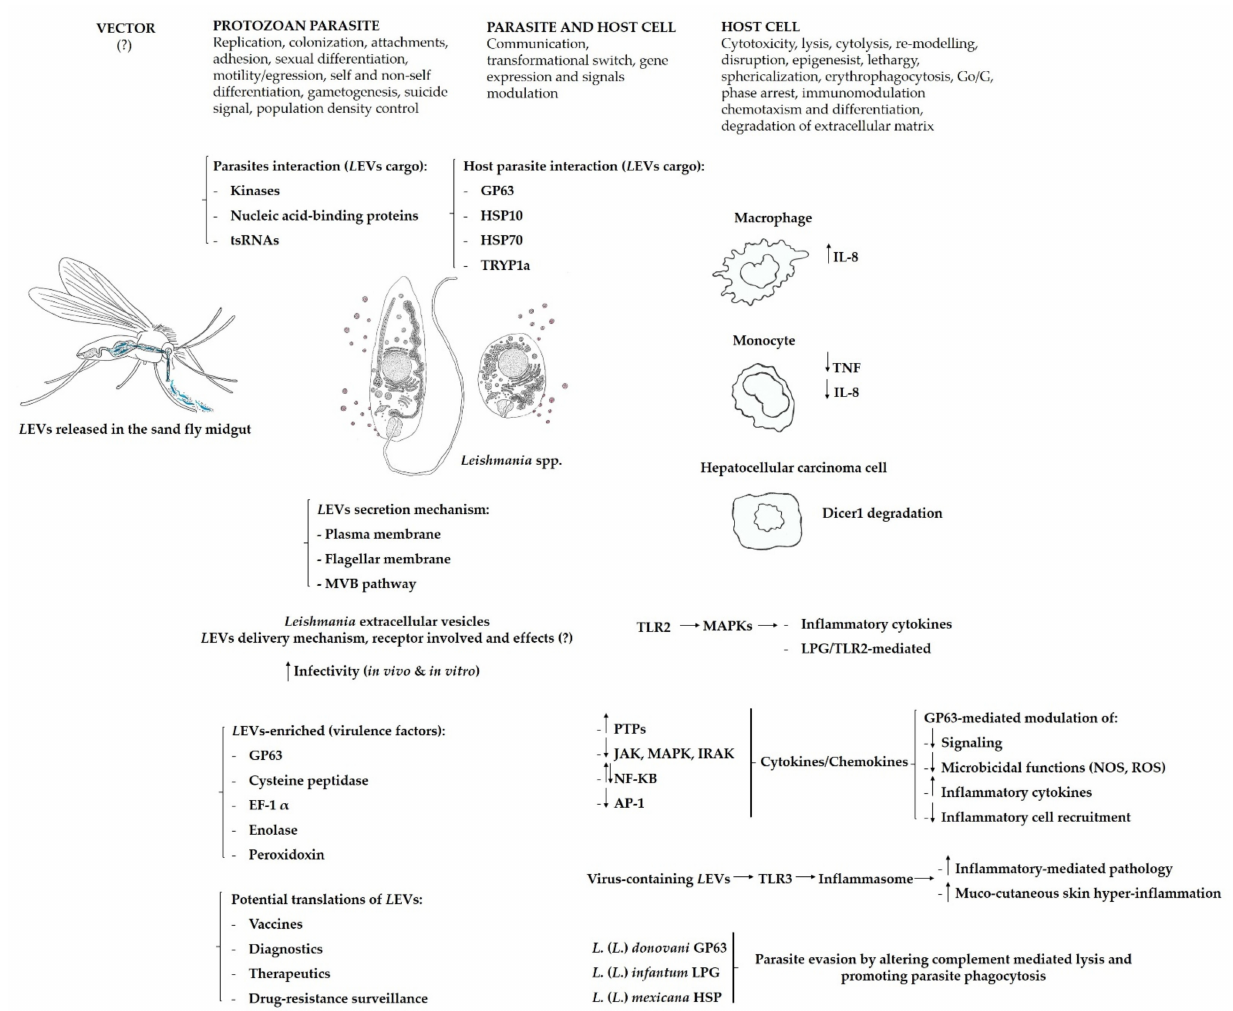
Figure 5. Extracellular vesicles as vehicles between Leishmania and host cell communication